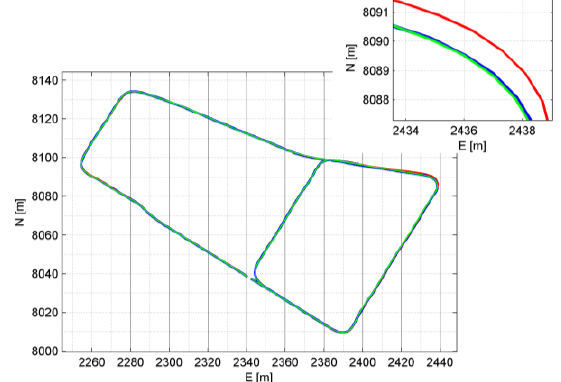
Figure 3. Trajectories estimated considering different photogrammetric block constrains and GPS reference trajectory (blue represents the GPS reference trajectory, red the photogrammetric trajectory recovered using a pure cartographic constrain and green the integrated photogrammetric-GPS